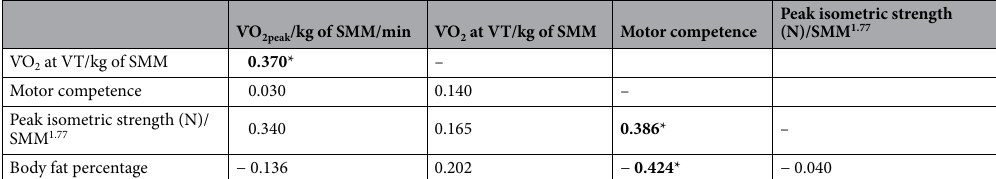
Table 2. Spearman correlation coefficients between the measures of cardiorespiratory fitness, motor competence, muscle strength, and adiposity. V ̇ O 2peak /kg of SMM/min = peak oxygen uptake scaled by skeletal muscle mass (SMM); V ̇ O 2 at VT/kg of SMM = oxygen uptake at ventilatory threshold scaled by skeletal muscle mass; N = Newtons. * p < 0.05. Statistically significant associations are given in